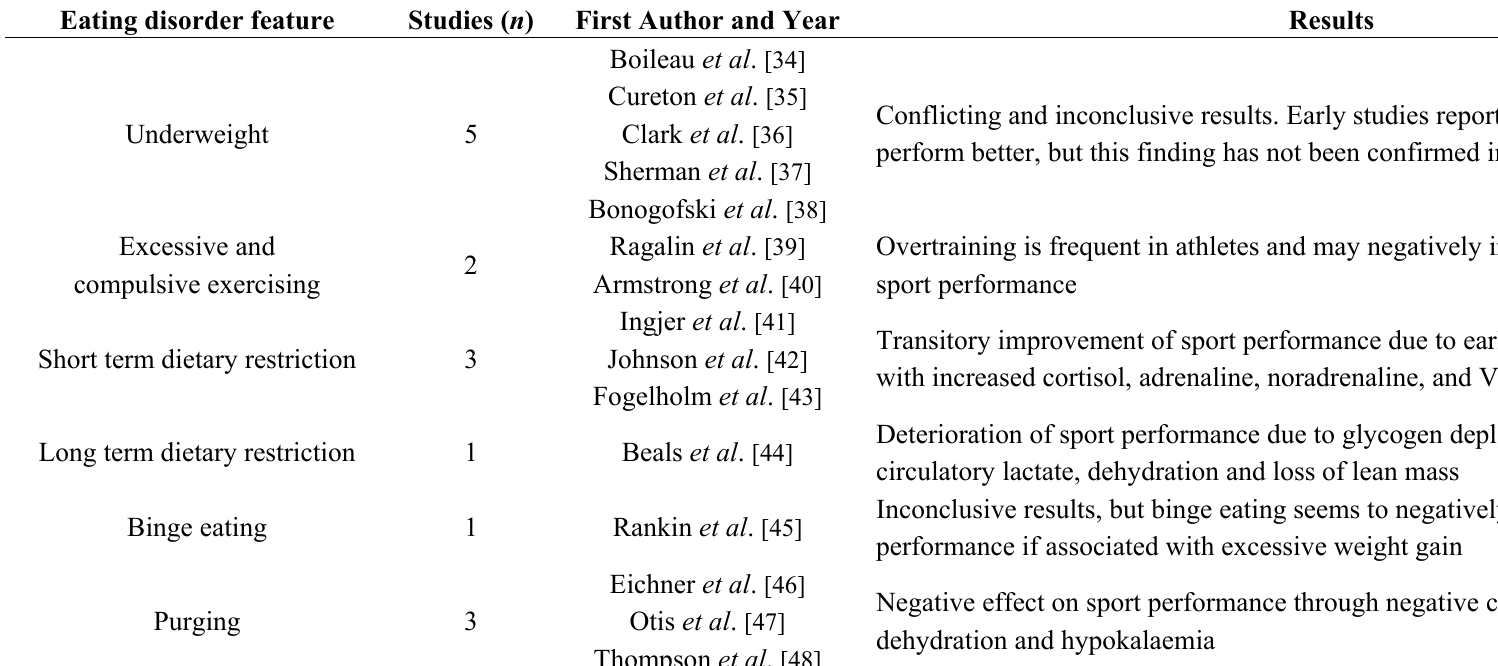
Table 2. Studies assessing the effect of eating disorders features on sport